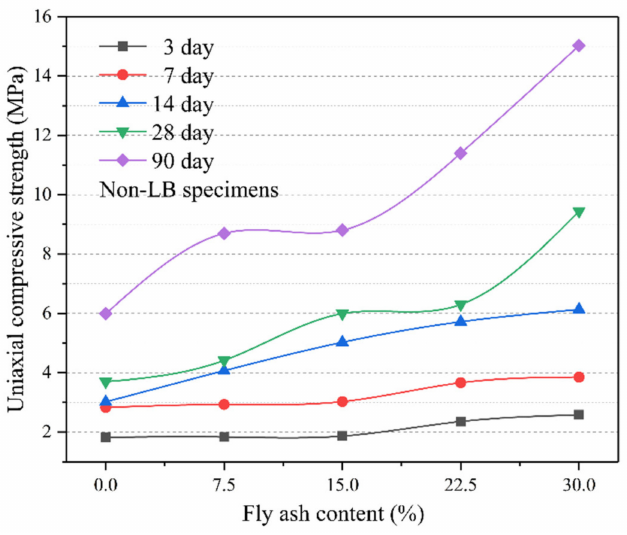
Figure 9. Influence of FA content and curing time on the uniaxial compressive strength of Non-LB specimens.